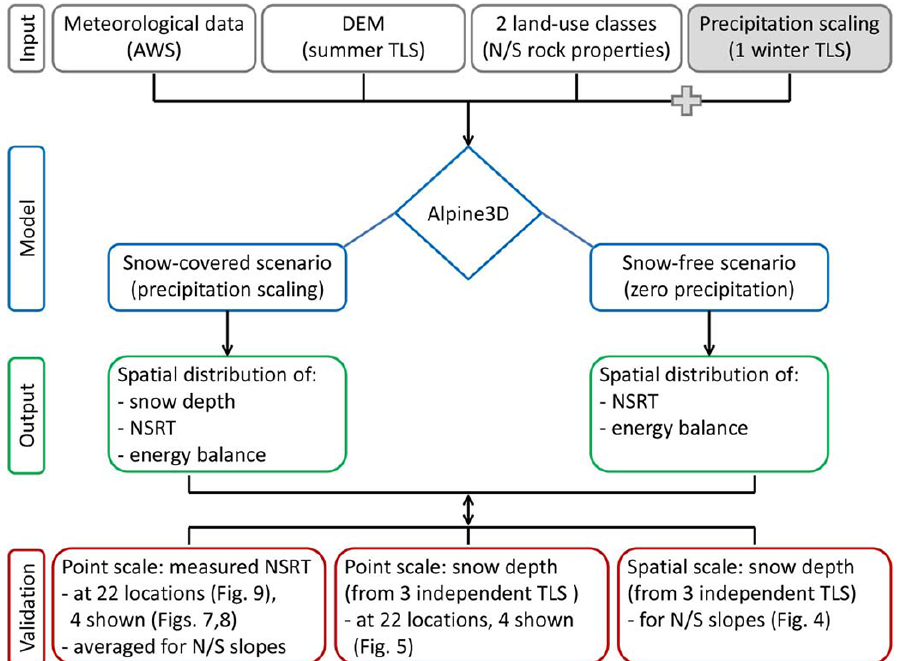
Figure 2. Flow chart of the methods applied in order to run the numerical model Alpine3D and to validate the model output at both the point and the spatial